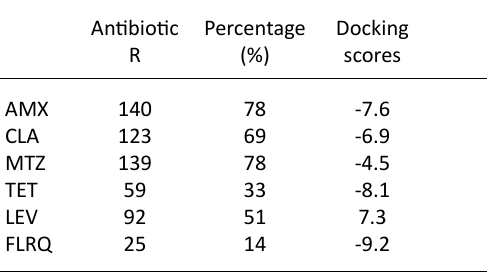
Table 4. Comparison of docking score and patients based survey data to represent the